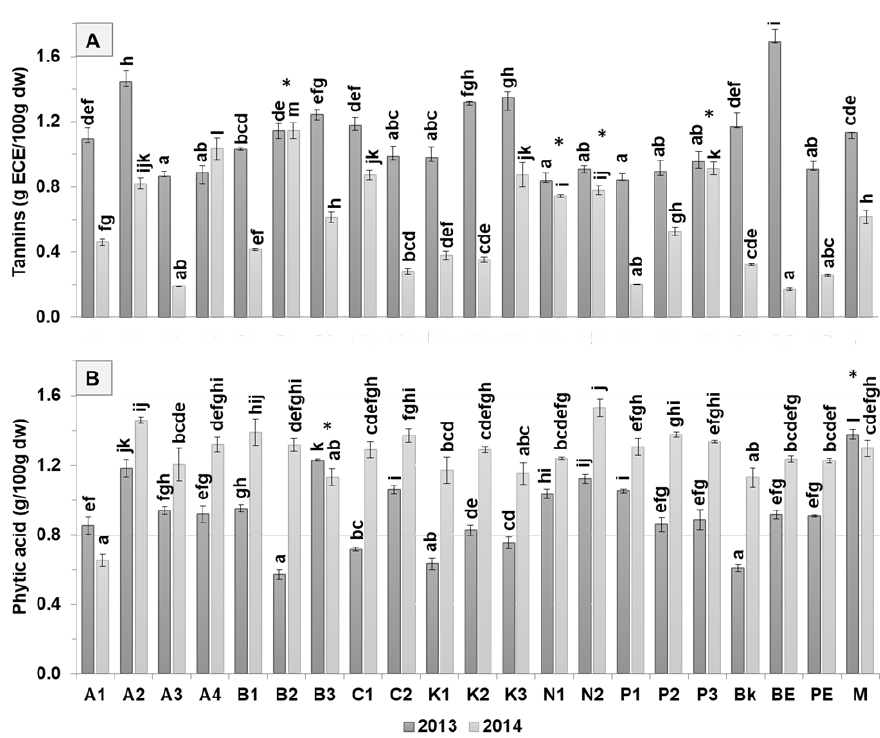
Figure 4. Antinutritional composition of 10 common bean cultivars, grouped according to their morphological characteristics: ( A ) tannins and ( B ) phytic acid content from 2013 and 2014. Cultivars: Arikara yellow (A1, A2, A3, A4), butter bean (B1, B2, B3), cranberry (C1, C2), red kidney (K1, K2, K3), navy (N1, N2), pinto (P1, P2, P3), black (Bk), brown eyed (BE), pink eyed (PE), and tarrestre (M). The absence of common letters (a–l) indicates significant differences at p < 0.05; Tukey’s multiple range tests were performed for each year separately. *indicates that it does not differ significantly at p < 0.05, between two harvesting years.